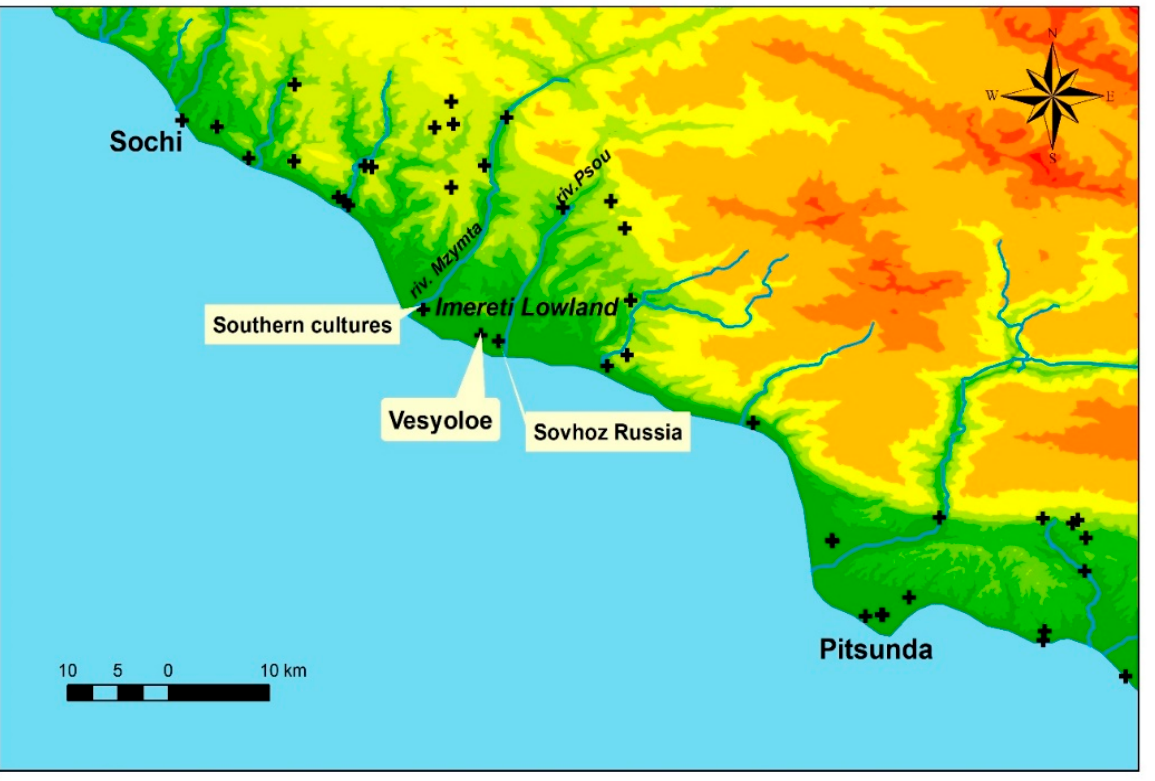
Figure 10. Temples in the Imereti Lowlands.